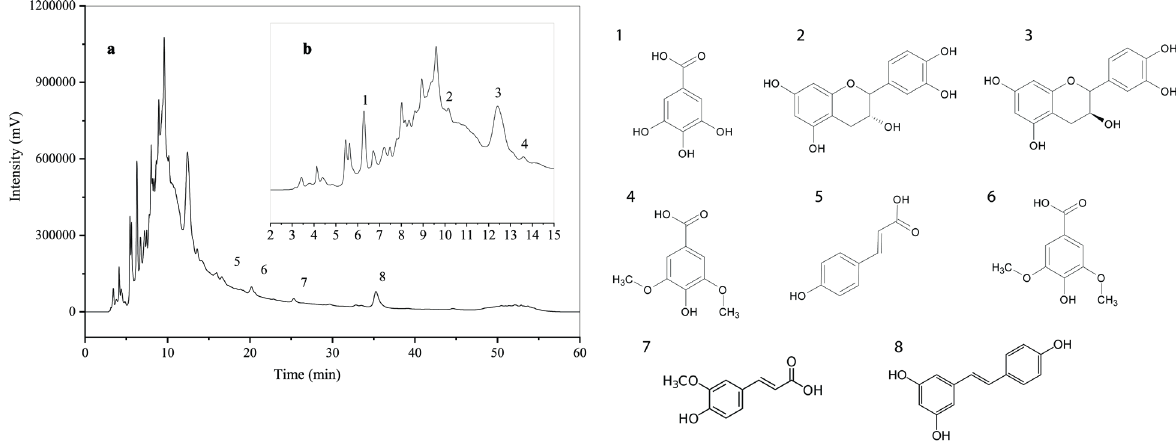
Figure 2 - ( a ) Chromatogram of jabuticaba skin flour aqueous extract, with peak identification: 1. gallic acid (time = 6.281 min); 2. catechin (time = 10.150 min); 3. epigallocatechin gallate (time = 12.405 min); 4. epicatechin (time = 13.587 min); 5. syringic acid (time = 15.936 min); 6. p -coumaric acid (time = 20.183 min); 7. ferulic acid (time = 25.299 min) and 8. resveratrol (time = 35.263 min). ( b ) expansion of the chromatogram at times from 2 to 15 min.